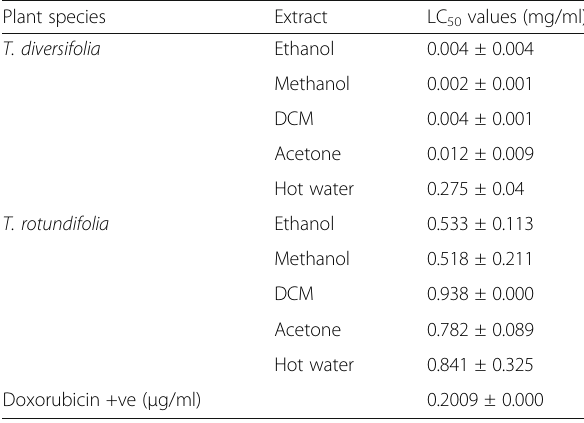
Table 5 LC 50 values of T . diversifolia and T . rotundifolia solvent extracts against Vero Monkey kidney